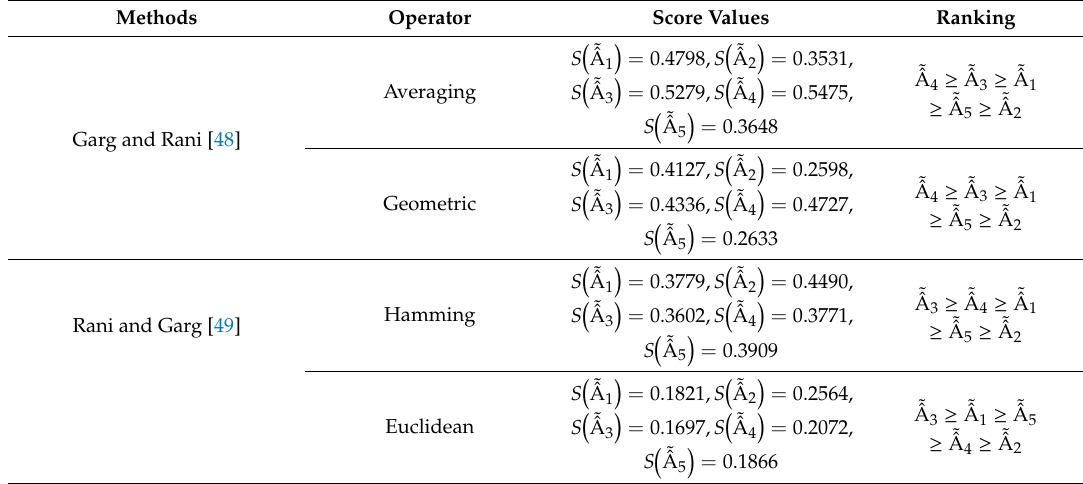
Table 2. Comparative analysis of the proposed method with the existing